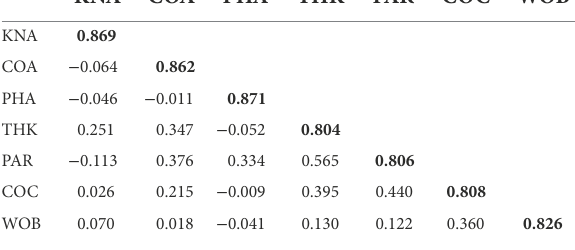
TABLE 2 Fornell-Larcker criterion test.